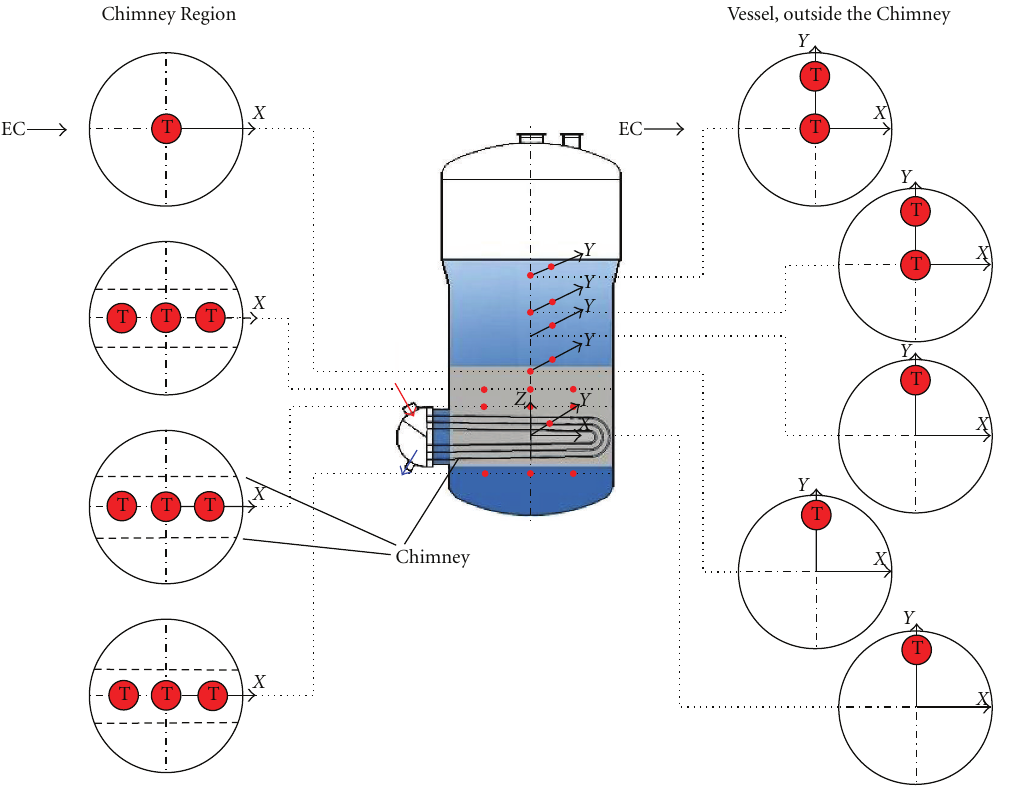
Figure 8: Instrumentation of the water volume of the Flooding Pool